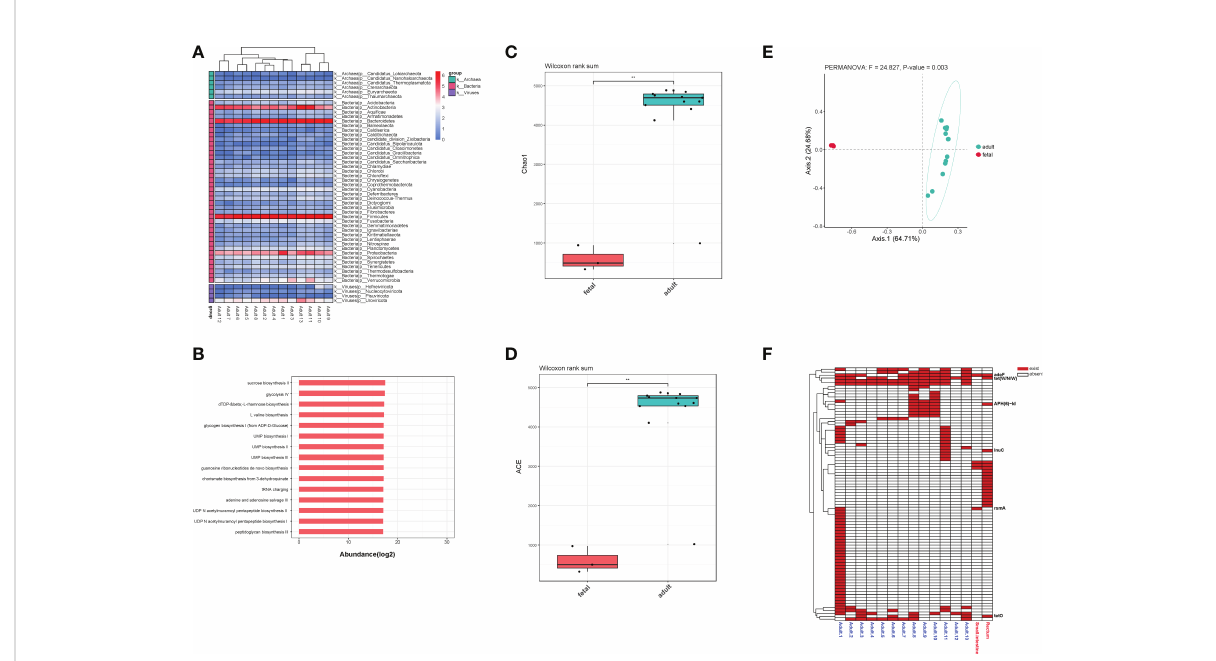
FIGURE 6 (A) The distribution of bacteria, archaea and viruses in each adult sample at phylum level. (B) Pathway enrichment analyses of adults ’ gut microbiota. (C) . Alpha diversity (Chao1 index) estimates between fetal and adult groups. (D) Alpha diversity (ACE index) estimates between fetal and adult groups. (E) The PCoA plot based on Bray-Curtis distance. (F) The distribution of all ARGs in fetal and adult groups. ** means p<0.05, and we chose p value cutoff of 0.05 as the signi fi cance